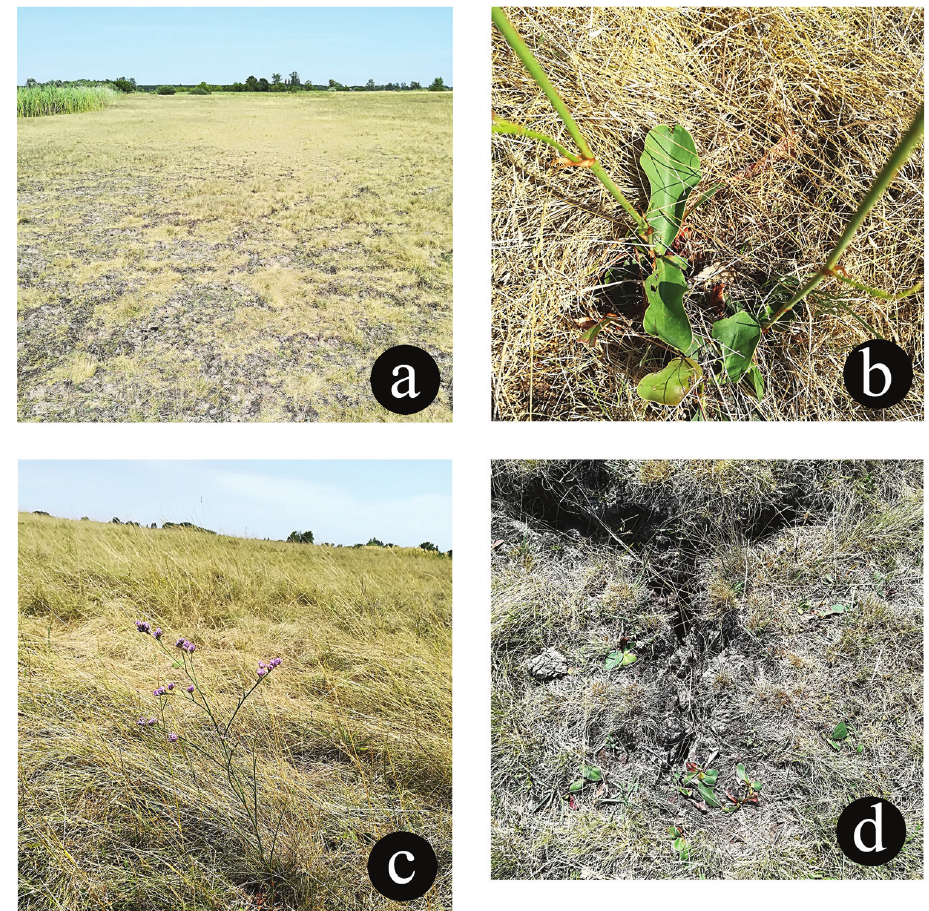
Figure 28. Habitat and details of the host plant. a Habitat b Host plant c–d Leaves of host Dorsum (Figure 29): Anterior margin of prodorsal shield with paired projections, depth of notch 16. Prodorsum smooth medially, with some striae laterally; antero- lateral projections carrying setae sc2 weakly formed. Opisthosoma smooth anteriorly, with posteromedial reticulation and posterolateral longitudinal striation. Propodoso- mal setae as follows: v2 short and smooth, sc1 broad and obovate, sc2 long and phyl- liform. Opisthosomal setae: c1, c3 and d1 broad, long, oblanceolate, d3 short and oblanceolate, e1 short and smooth, h1, f1, f2 and e3 long, oblanceolate, h2 very long and smooth. Rostrum extending to middle of tibia I. Opisthosomal pores between d1 and e1 . Length of dorsal setae: v2 9–10, sc1 30–32, sc2 65, c1 45–46, c3 32–34, d1 38–40, d3 12–14, e1 12, e2 45–47, f2 and f3 45–46, h1 36–37, h2 105–110. Venter (Figure 30): Very few striations observable in the holotype, only a few lon- gitudinal striations visible posterior to g1 – g2 . Genital and anal plates smooth. Length of ventral setae, 1a 120–122, 3a 26–27, 4a 130–133, 1b 16, 2b 16–17, 3b 18–19, 4b